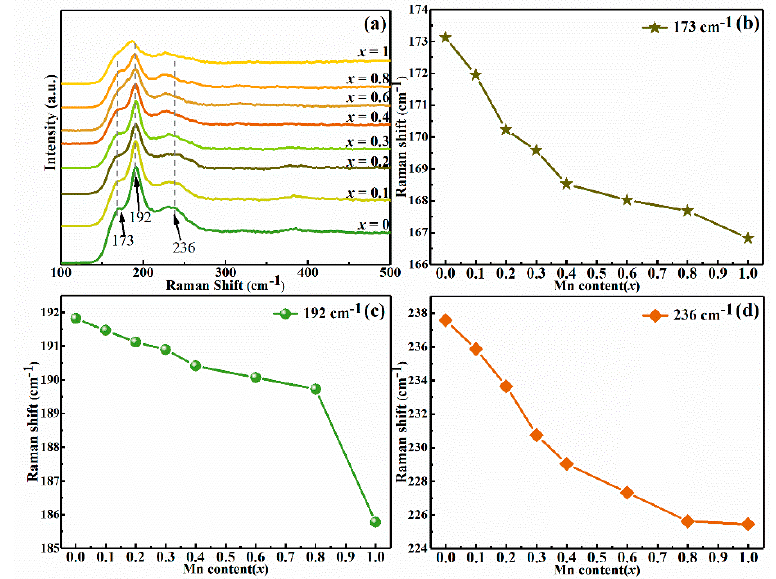
Figure 3. ( a ) Raman spectra of the Cu 2 Mn x Zn 1 − x Sn(S,Se) 4 (0 ≤ x ≤ 1) thin films. The variations of the Raman peaks position with the Mn content for the Cu 2 Mn x Zn 1 − x Sn(S,Se) 4 (0 ≤ x ≤ 1) alloy thin films: ( b ) 173 cm − 1 , ( c ) 192 cm − 1 , and ( d ) 236 cm − 1 .